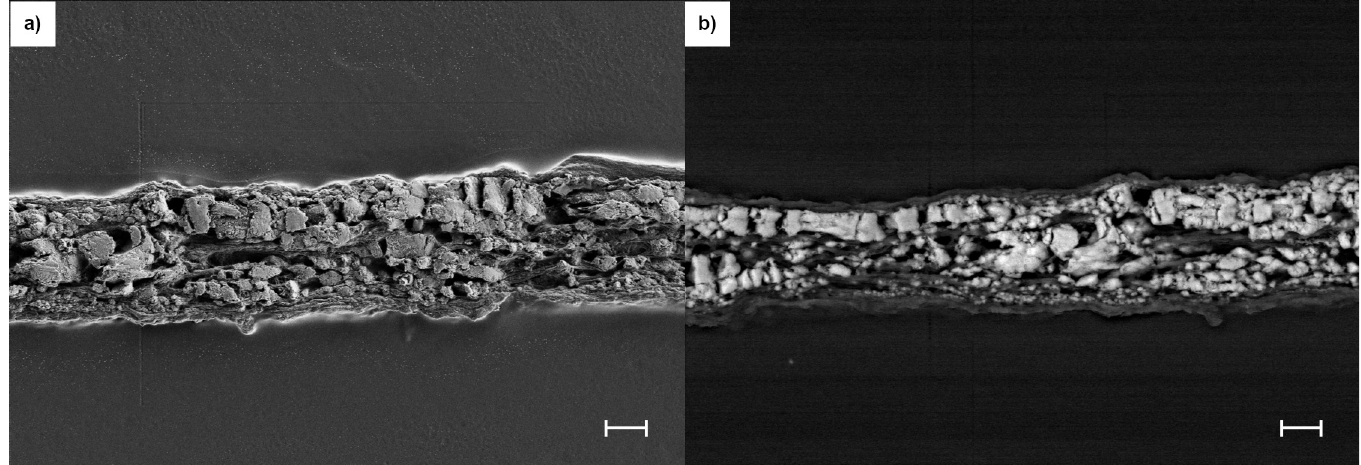
Fig 12. SEM secondary (a) and backscattered (b) electron images from a no-PEMF ring construct frozen section at Day 63. SEM settings for (a): EHT = 3KeV, WD = 4.4 mm, H = 128.3 μ m, W = 171.0 μ m. Scale Bar = 10 μ m. SEM setting for (b): EHT = 15KeV, WD = 11.0 mm, H = 128.3 μ m, W = 171.0 μ m. Scale Bar = 10 μ m.